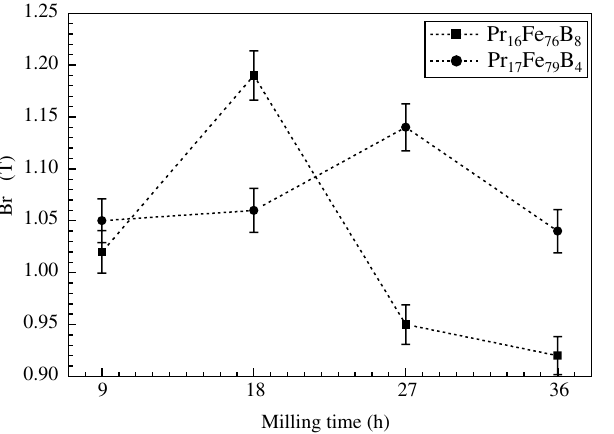
Fe B and Pr Fe B HD magnets, as a function 16 76 8 17 79 4